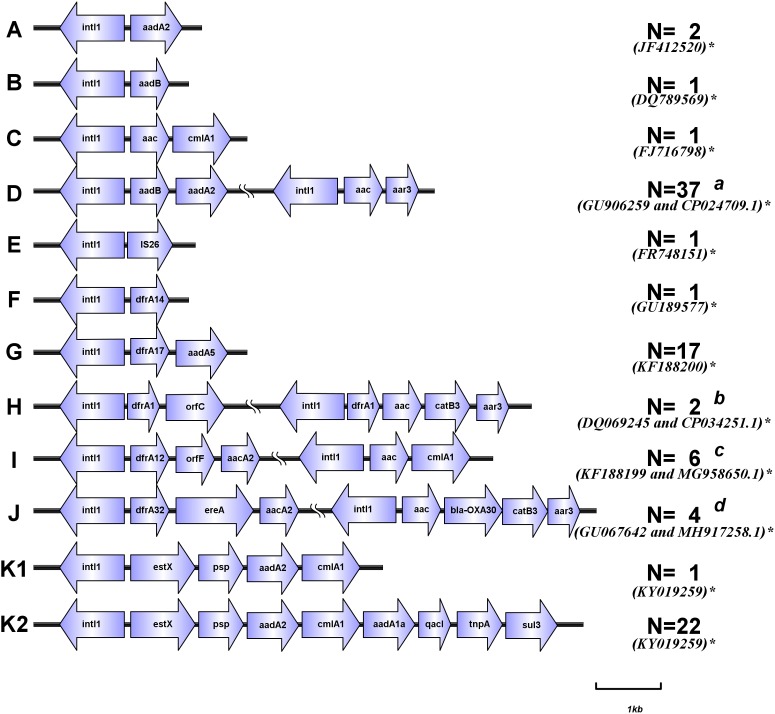
Schematic representation of different types of gene cassette arrays (aac equal to aac(6′)-Ib or aac(6′)-Ib-cr). ∗Accession numbers in Genbank. aAmong the 37 isolates, 25 of the integron variable regions were aadB-aadA2, and the other 12 were aadB-aadA2 and aac(6′)-Ib-aar3. bAmong the 2 isolates, 1 of the integron variable regions were dfrA1-orfC, and the other 1 was dfrA1-orfC and dfrA1- aac(6′)-Ib -catB3-aar3.
cAmong the 6 isolates, 5 of the integron variable regions were dfrA12-orfF-aacA2, and the other 1 was dfrA12-orfF-aacA2 and aac(6′)-Ib -cmlA1, the second array (aac(6′)-Ib -cmlA1) is the same as C(aac(6′)-Ib -cmlA1). dAmong the 4 isolates, 3 of the integron variable regions were dfrA32-ereA-aacA2, and the other 1 was dfrA32-ereA-aacA2 and aac(6′)-Ib -bla-OXA-1-catB3-aar3. (Sequences of PCR products were analyzed with BLAST to identify target homologous sequences and their GenBank accession numbers. https://blast.ncbi.nlm.nih.gov/Blast.cgi).